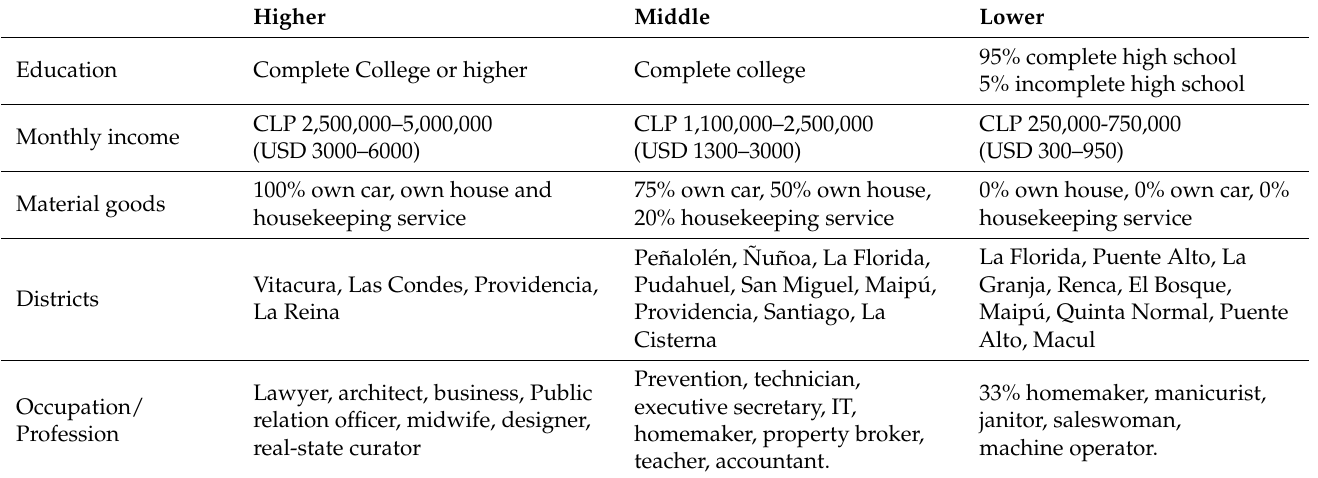
Table 1. Profile of